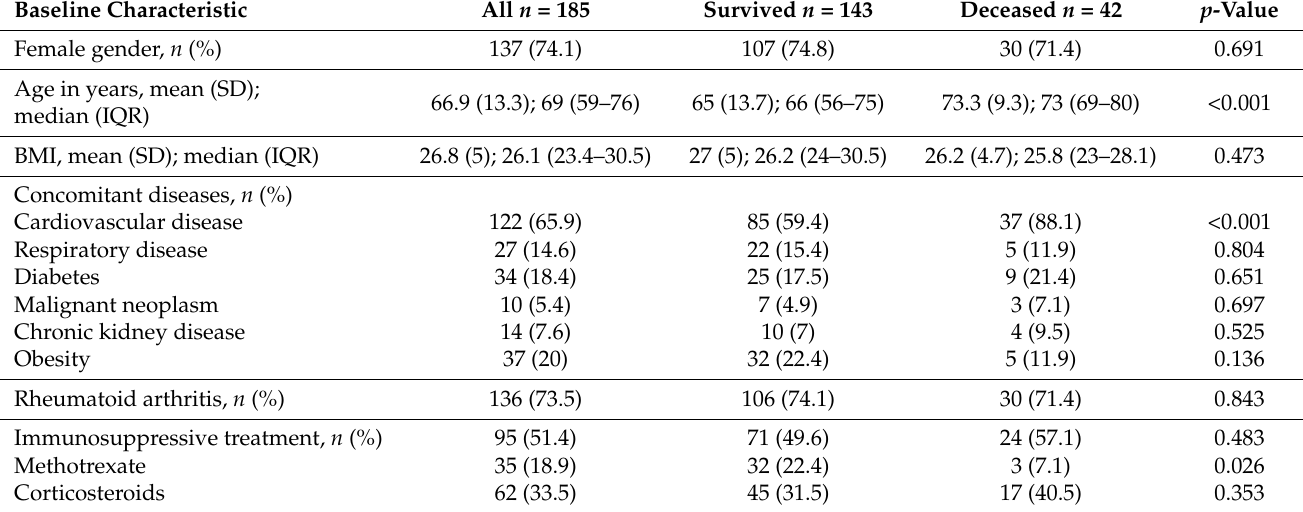
Table 1. Basic demographic and medical data in the group of patients with